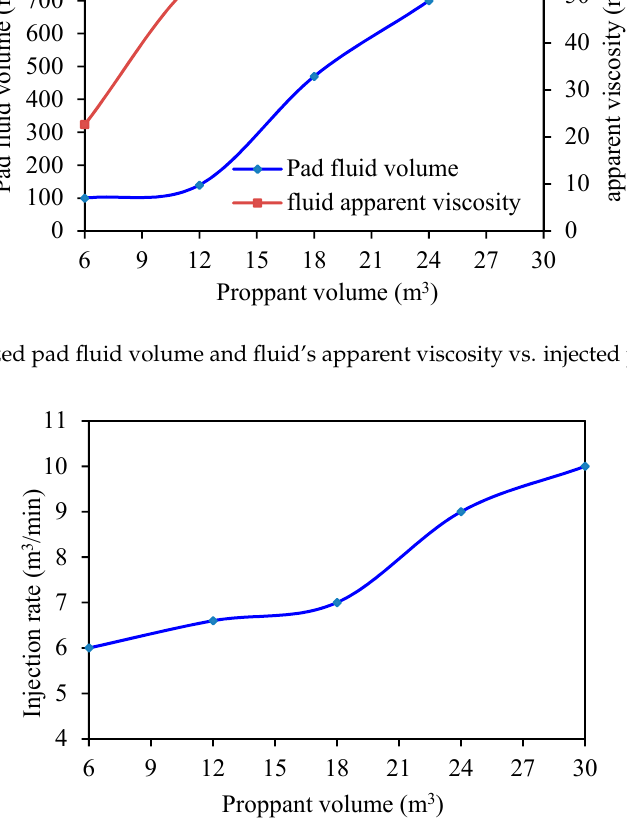
Figure 22. Optimized injection rate vs. injected proppant volume.